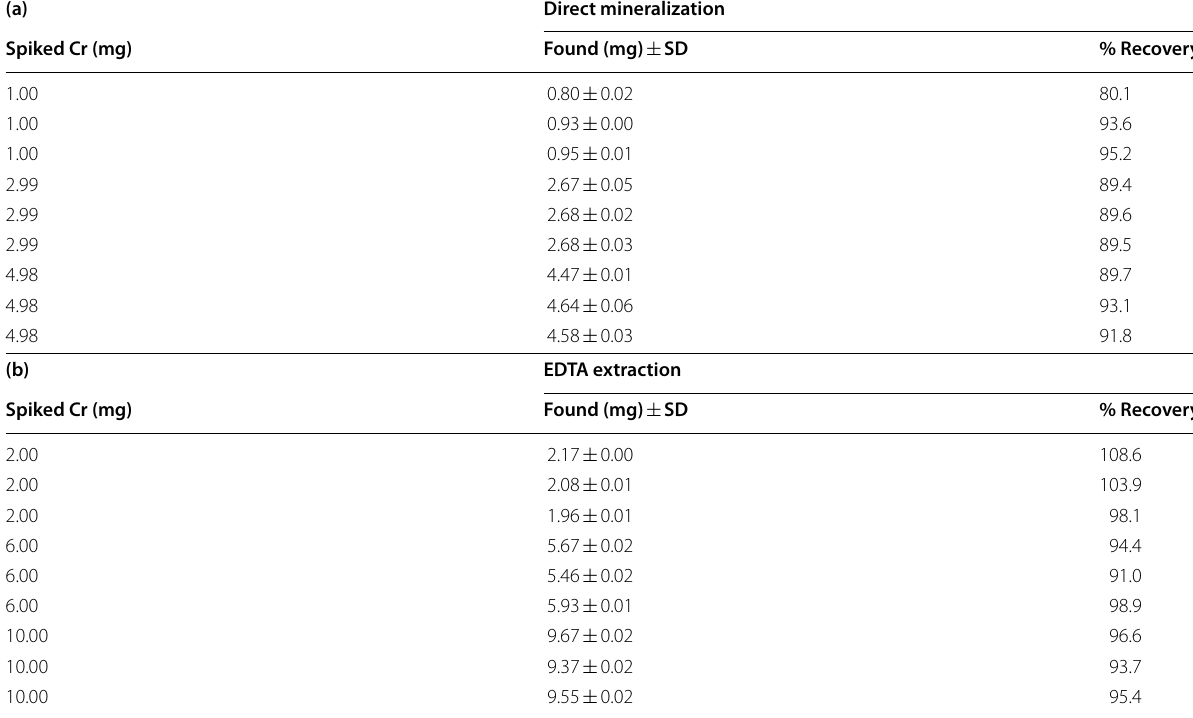
Table 5 Spike recovery for: a direct mineralization; b EDTA extraction (a) Direct mineralization Spiked Cr (mg) Found (mg)